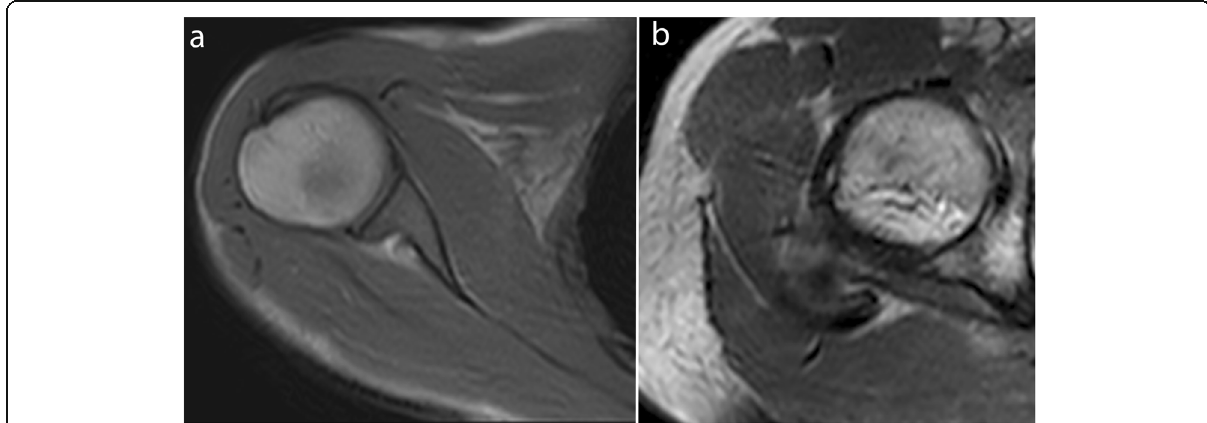
Fig. 1 Real-time dynamic MR images obtained with balanced SSFP sequence at 3.0 T. Shoulder in the axial plane in external rotation ( a ) and hip in the axial plane in external rotation ( b ) (TR, 4.2; TE, 2.1; flip angle, 40°; pixel size, 1.37 × 1.83